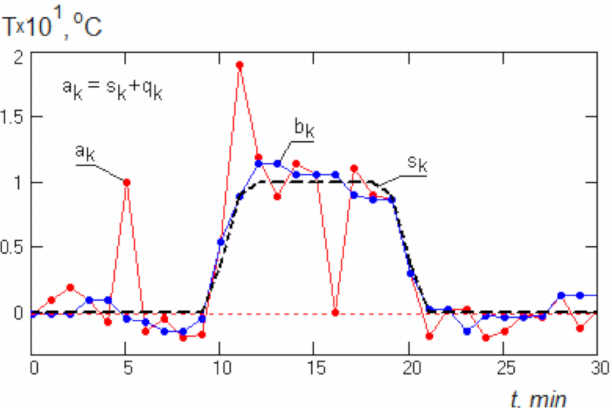
Figure 3. Example of applying median filtering to a model signal: a k is the model signal; b k is the result of median